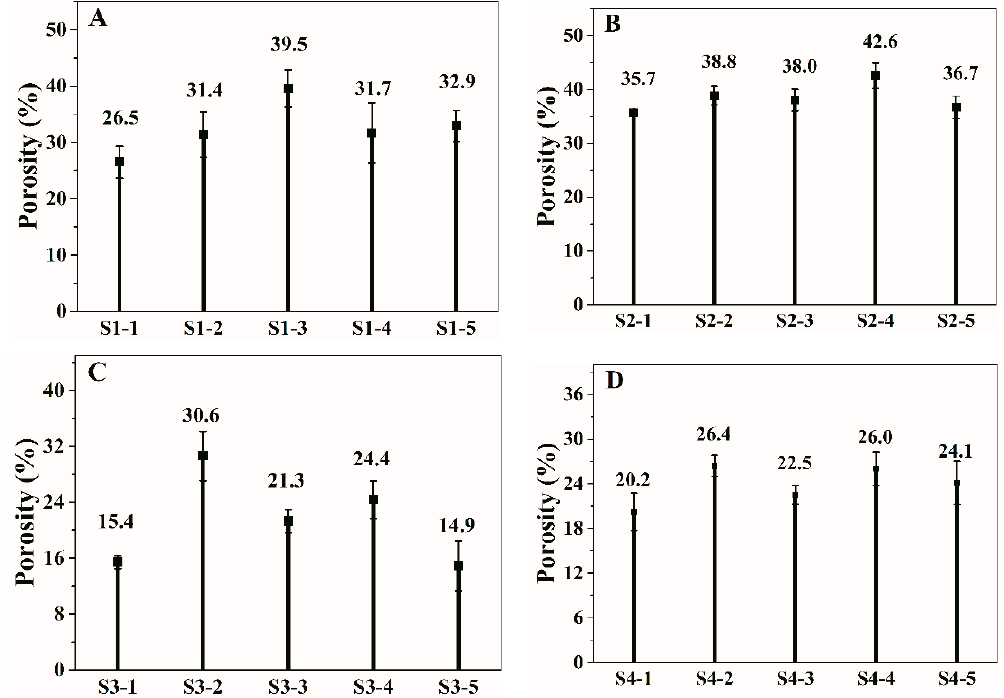
Figure 3. The porosity of the p(OPal-MMA) membranes prepared by different mix solvents. ( A ), S1; ( B ), S2; ( C ), S3; ( D ), S4.